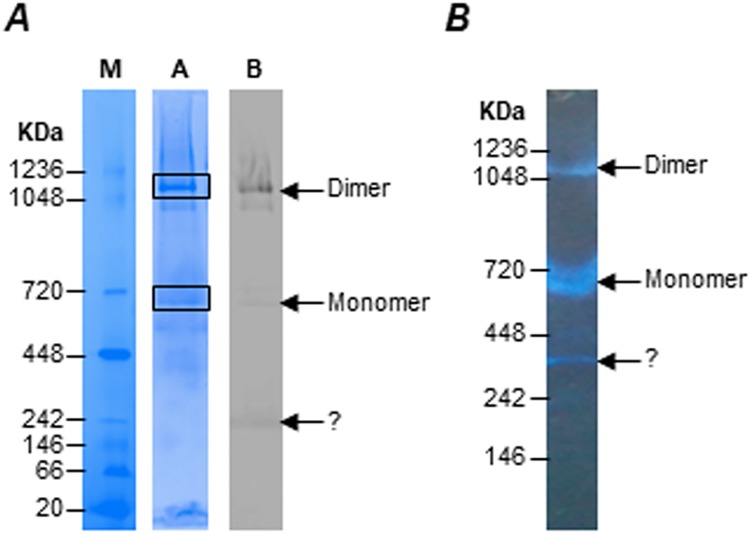
Identifying the dimer and monomer forms of T. gondii F-type ATP synthase by BNP analysis.(A) Mitochondria lysates were prepared from tachyzoites stage transgenic parasites expressing TgATPβ-YFP-HA protein were separated by BNP. Lane M, native molecular weight markers; lane A, Coomassie blue staining of BNP gel; lane B, western blotting of BNP gel using α-HA antibodies. The dimer and monomer forms are indicated by arrows. The boxed regions in lane A correspond to the excised gel pieces, which were processed for LC-MS/MS analysis. (B) In-gel ATPase activity assays following BNP separation confirms that the dimer and monomer forms of F-type ATP synthase are functionally intact. BNP, blue native PAGE; HA, hemagglutinin; LC-MS/MS, liquid chromatography–tandem mass spectrometry; TgATP-β, T. gondii ATP synthase β subunit; TgATP-OSCP, T. gondii ATP synthase OSCP subunit; YFP-HA, yellow fluorescent protein plus hemagglutinin.